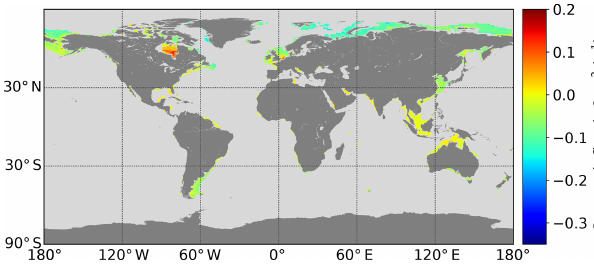
Figure 7. Mean annual sea-to-air CO 2 flux of shelf seas in 2010 using the Zappa et al. (2007) gas transfer relationship for all regions and months with wind speeds 0 to 10ms − 1 . Shelf regions are de- fined as having depths between 20 and